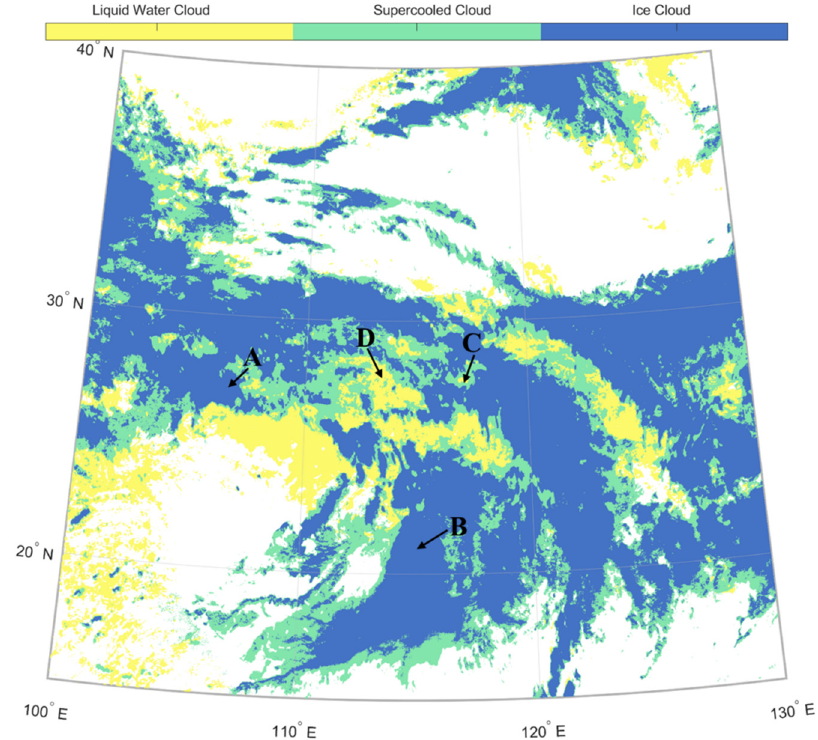
Figure 4. Cloud phase of FY-4A satellite at 06:30 UTC on 21 May 2020 after K-mean cluster and combined with a 10.8 µm brightness temperature to obtain the distribution of water, supercooled water, and ice clouds. A, B, C, and D correspond to Figure 2.